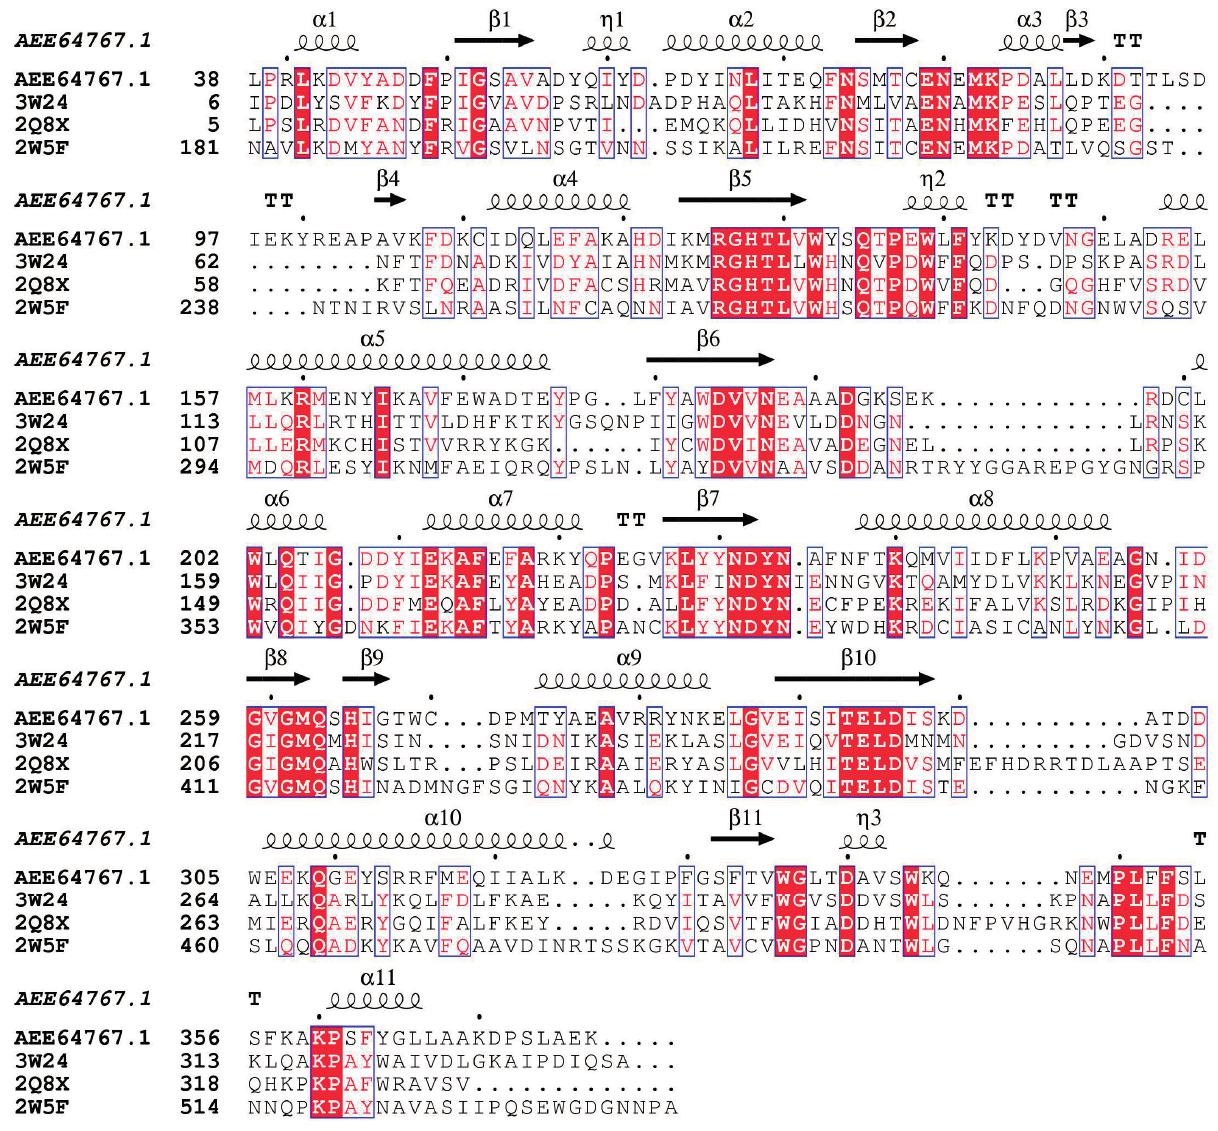
Figure 2. Sequence alignment of Xyn10A with other members in the GH10 superfamily. Xyn10A: (GenBank: AEE64767.1) [13]; 3W24: intracellular xylanase from Thermoanaerobacterium saccharolyticum JW/SL-YS485(PDB Id 3W24) [7]; 2Q8X: the thermophilic, intracellular xylanase from G. Stearothermophilus (PDB Id 2Q8X) [38]; 2W5F: the N -terminal endo-1,4- β - D -xylanase 10 b (Xyn10b) of C. thermocellum (PDB Id 2W5F) [19]. Strictly conserved residues are highlighted by red background and conservatively substituted residues are boxed. The secondary structural elements (helices- α , strands- β , turns-T) of Xyn10A are shown above the aligned sequences. The conserved catalytic residues E186 and E294 are indicated by black triangle. The figure was produced using ESPript